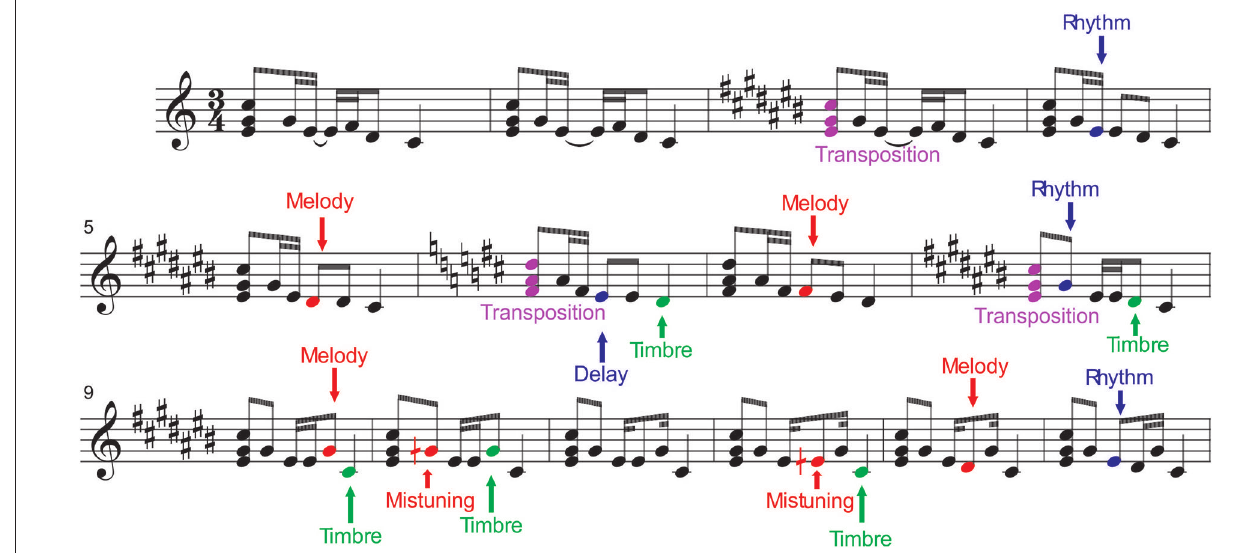
or selectively in some of them (pitch/timbre/harmony/timing). In particular, we hypothesized that folk musicians would show superior automatic neural discrimination of low- and high-level features related to pitch, such as mistuning, as a result of the emphasis given in Finnish folk music to the melodic aspects over rhythmic ones (for details on Finnish folk music, see Saha, 1996; Asplund et al., 2006; Brattico et al., 2013). This would indicate that the specific features of each music genre can have their imprints in the neural architecture of the